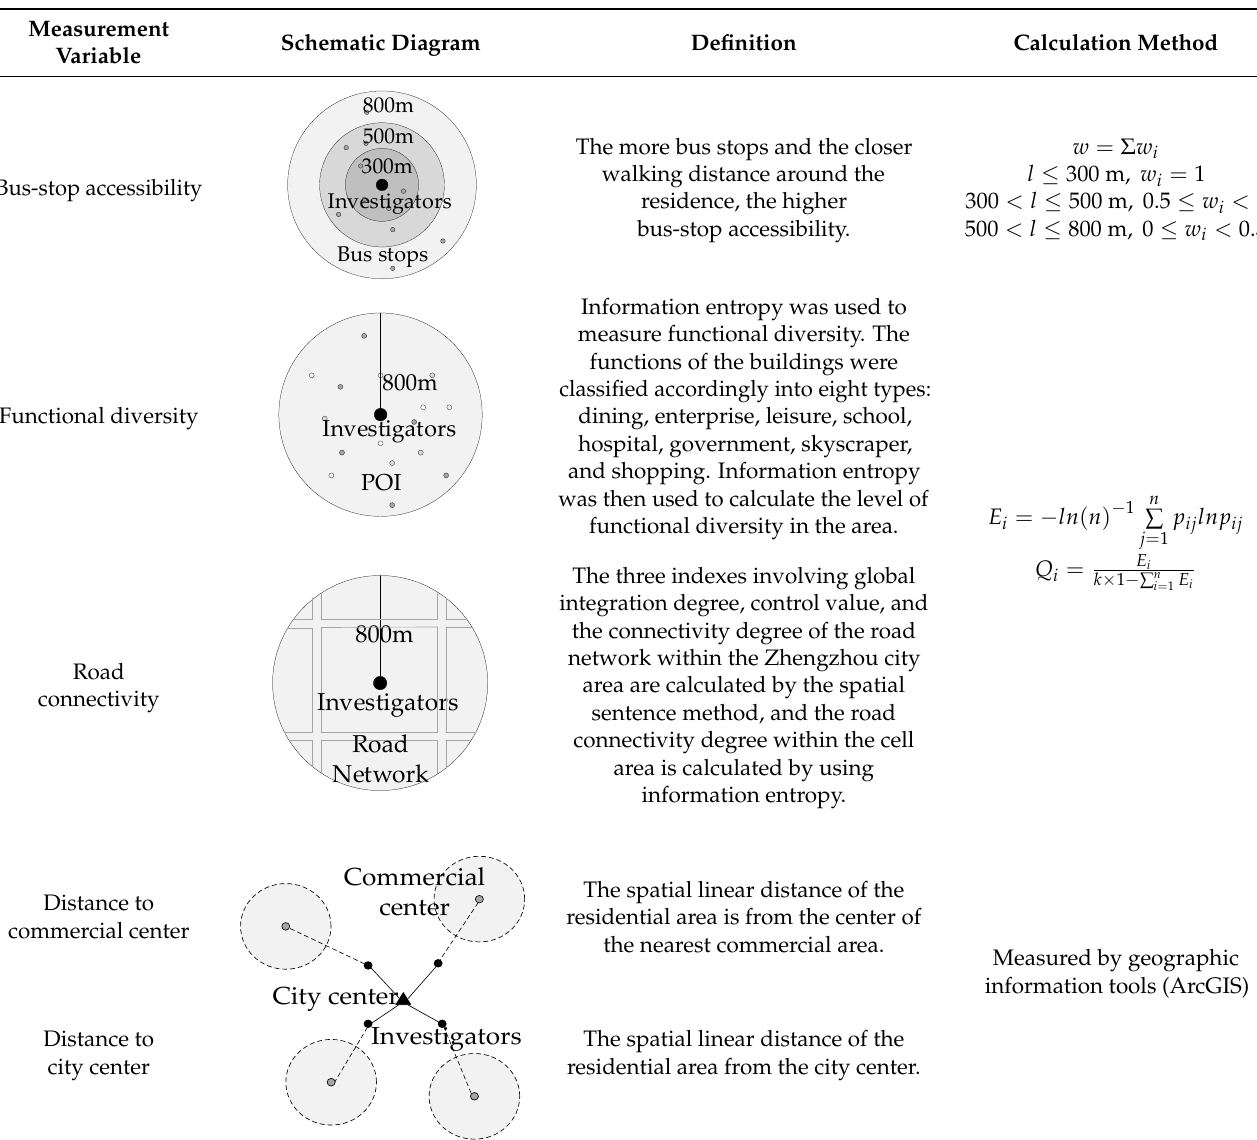
Table 2. Definition of the bus travel environment.